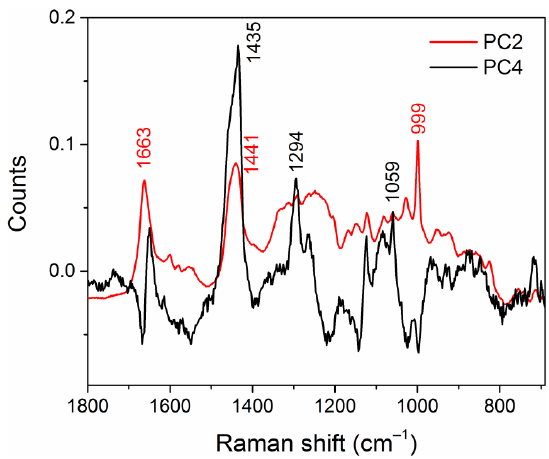
Fig. 7. Loading plots of the principal components (PCs) obtained from the analysis of a micro-Raman map of a TASTPM mouse brain hippocampal section. Peak positions of the main bands are labeled.